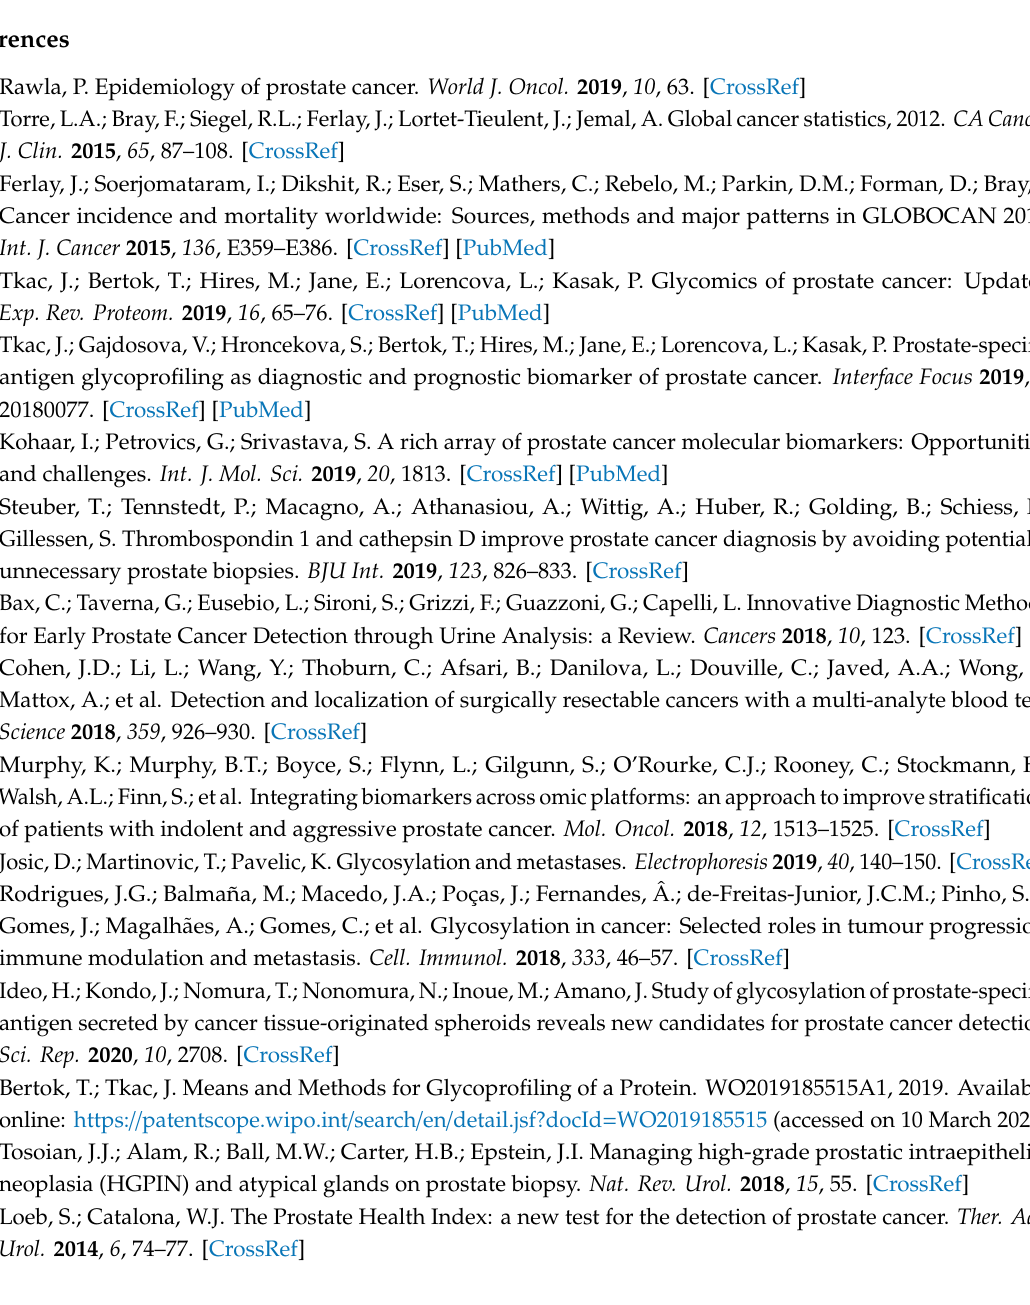
Table S3: Individual markers (1st section), their selected combinations (2nd section), selected combinations with interactions (3rd section) and corresponding sensitivities, specificities, accuracies, and AUC values obtained from ROC curves. In the 3rd section, tPSA and fPSA markers were deliberately omitted to lower the amount of significant markers entering the analysis down to six. These two markers did not have a significant impact on the analysis performance, Table S4: Number of missed cancers by Gleason score for glycan-based biomarkers, PHI and fPSA% (90% sensitivity). References [29–36] are cited in the Supplementary